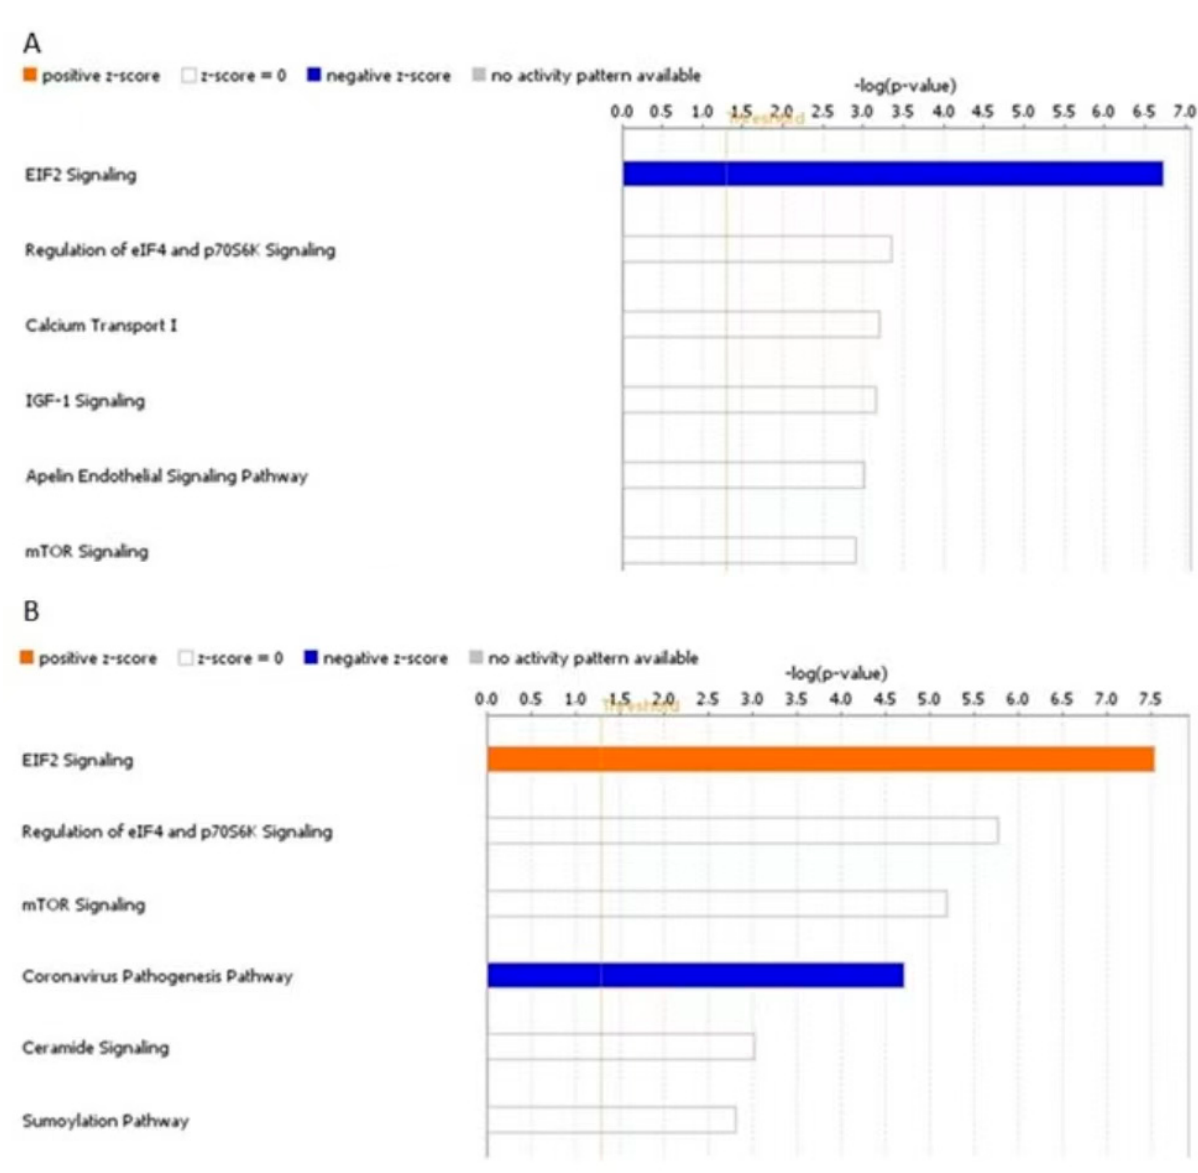
Figure 10. Top canonical pathways linked to DE proteins from human OA chondrocytes treated with miR-143-3p mimic, inhibitor or control. Human OA chondrocytes were treated in media supplemented with 10 ng/mL IL-1 β with miR-143-3p mimic, inhibitor or control for 48 h. Cell lysates were collected and subjected to LC-MS/MS. Figure depicts IPA Core Analysis of DE proteins from chondrocytes treated with ( A ) miR-143-3p mimic or control and ( B ) miR-143-3p inhibitor or control. Top canonical pathways associated with each dataset and z activation scores for each canonical pathway are shown. Figures generated with IPA Version 60467501.